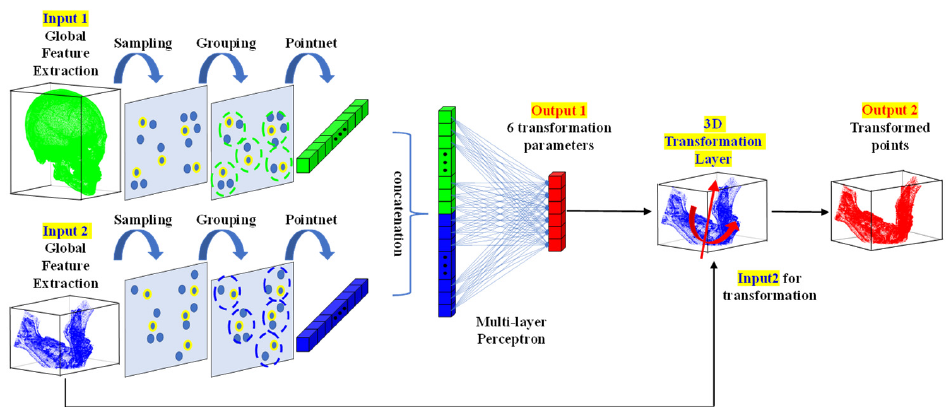
Figure 2. Three-dimensional point alignment network for prediction of postoperative result of orthognathic surgery.